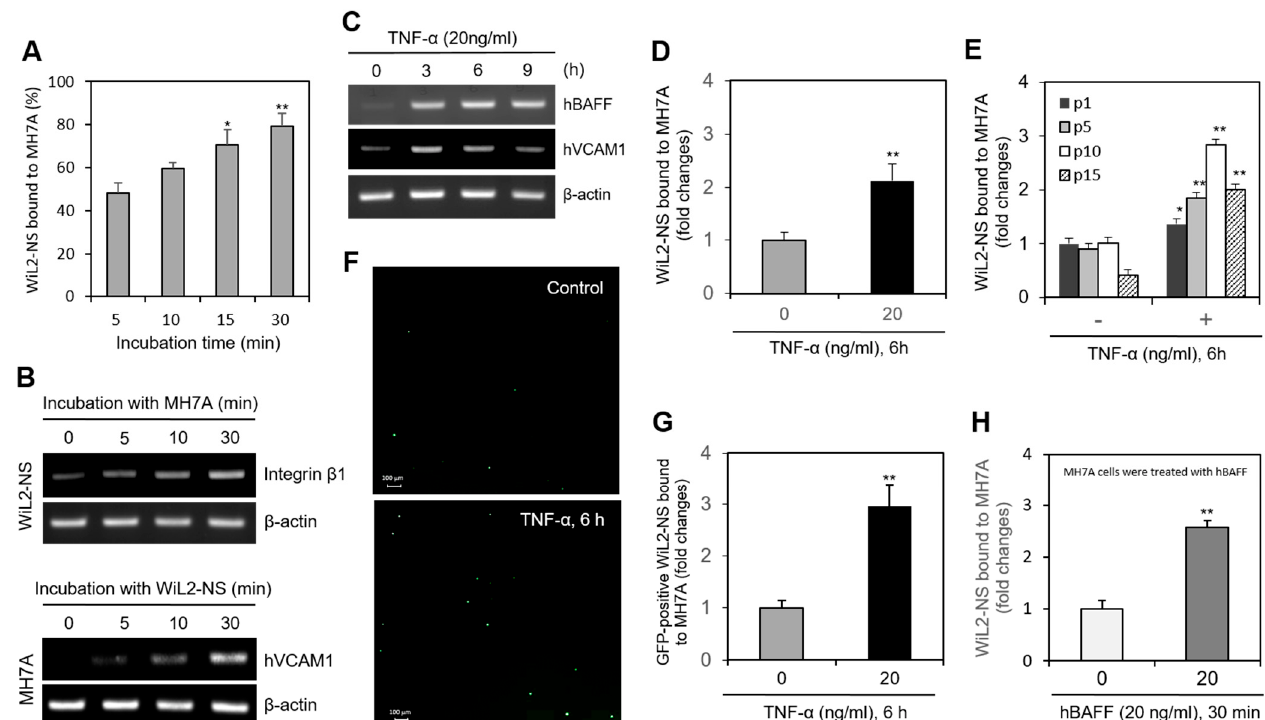
Figure 1. TNF- α enhanced a binding of B cells to synovial cells. ( A , B ) MH7A cells were plated overnight. Then, WiL2-NS cells were added and co-incubated to adhere for 5, 10, 15 and 30 min ( A ). Each cell was collected separately at each time point. RNA was purified with Nucleozol ® . The expression of human vascular cell adhesion molecule-1 (hVCAM1) and integrin β 1 in MH7A and WiL2-NS cells was respectively detected by RT-PCR ( B ). ( C ) Primary synoviocytes were treated with 20 ng/mL TNF- α for various times. RNA was purified with Nucleozol ® . The expression of hBAFF and hVCAM1 was detected by RT-PCR. ( D , E ) MH7A cells were plated overnight and treated with 20 ng/mL TNF- α for 6 h. Then, WiL2-NS cells were added and co-incubated to adhere for 30 min. Unbound WiL2-NS B cells were washed out and MTT assay was used to analyze bound B cells ( D ). WiL2-NS cell adhesion to MH7A cells of each passage were measured by MTT assay ( E ). ( F , G ) WiL2-NS cells were transfected with pSG5-GFP plasmid DNA by using Viafect ® . GFP-positive WiL2-NS cells were visualized under fluorescence microscope ( F ). Transfected WiL2-NS cells were co-incubated with MH7A cells at the ratio of 1:1 for 30 min. Unbound WiL2-NS B cells were washed out. Then, GFP-positive WiL2-NS cells were counted to analyze bound B cells ( G ). ( H ) MH7A cells were treated with hBAFF protein for 30 min. Then, WiL2-NS cells were added and co-incubated to adhere for 30 min. Unbound WiL2-NS B cells were washed out and MTT assay was used to analyze bound B cells. Each experiment was performed at least four times. Data in a bar graph represent the means ± SD. * p < 0.05, ** p < 0.01; significantly different from group with 5 min-incubation ( A ), TNF- α - ( D , E , G ) or hBAFF- ( H ) untreated control